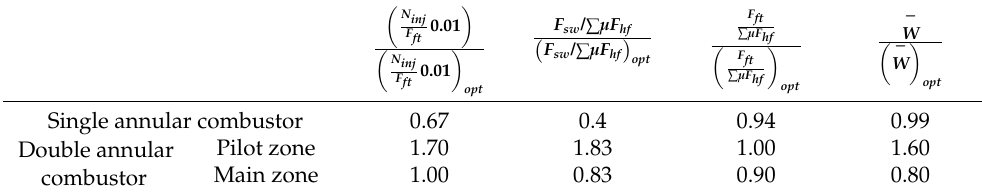
Table 3. Parameters of double annular